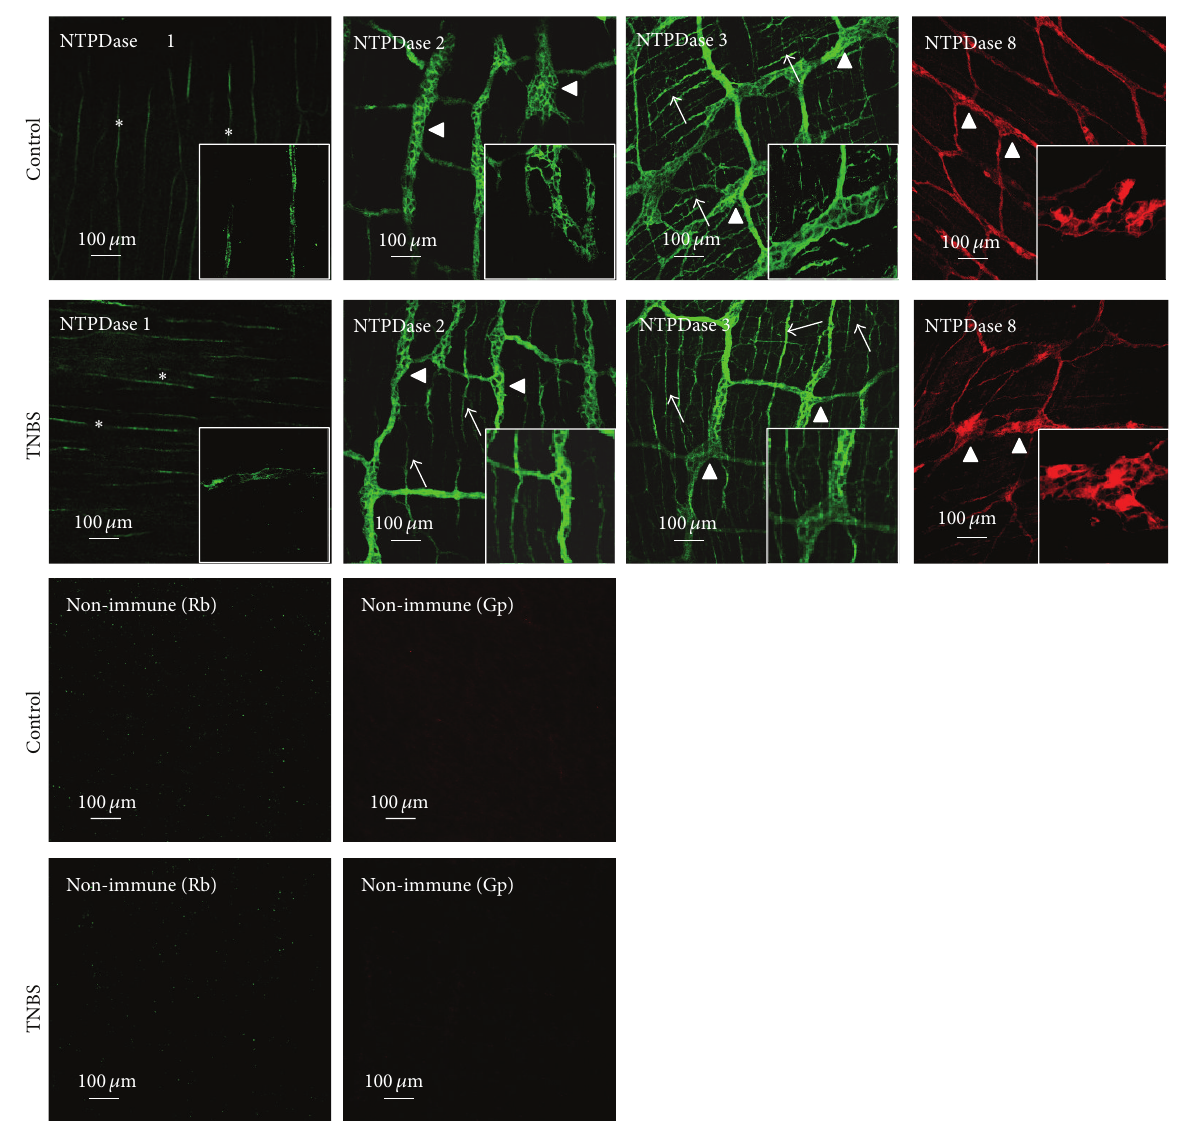
Figure 8: Localization of NTPDase1, NTPDase2, NTPDase3, and NTPDase8 immunoreactivity in single confocal images of whole-mount preparations of the longitudinal muscle-myenteric plexus of the ileum of control and TNBS-injected rats. In healthy animals, NTPDase 1 immunoreactivity is present only in blood vessels (asterisks); NTPDase2 immunoreactivity is present predominantly in ganglion neuronal cell bodies (triangles) and large ramifications (primary meshwork) of the myenteric plexus, whereas NTPDase3 is also evident on myenteric axon terminals (arrows). In TNBS-treated preparations the NTPDase2 staining acquires a pattern that is very similar to that of NTPDase3, with NTPDase2 immunoreactivity also appearing in nerve bundles and axon terminals of myenteric neurons. NTPDase8 stains few ganglion neuronal cell bodies and large ramifications (primary meshwork) of the myenteric plexus; this pattern did not significantly change among control and TNBS-treated animals. No staining was obtained when nonimmune sera from host species (rabbit, Rb, and guinea-pig, Gp) were used instead of interest primary